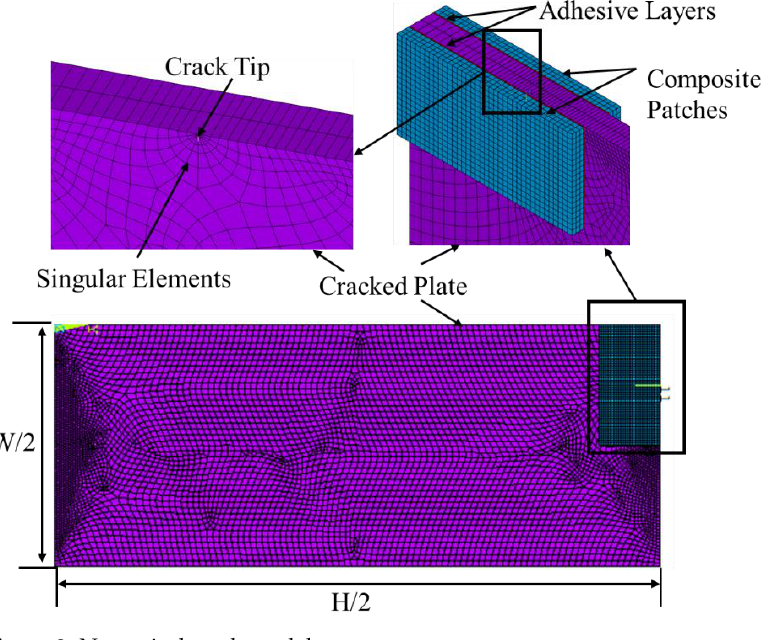
Figure 2. Numerical mesh